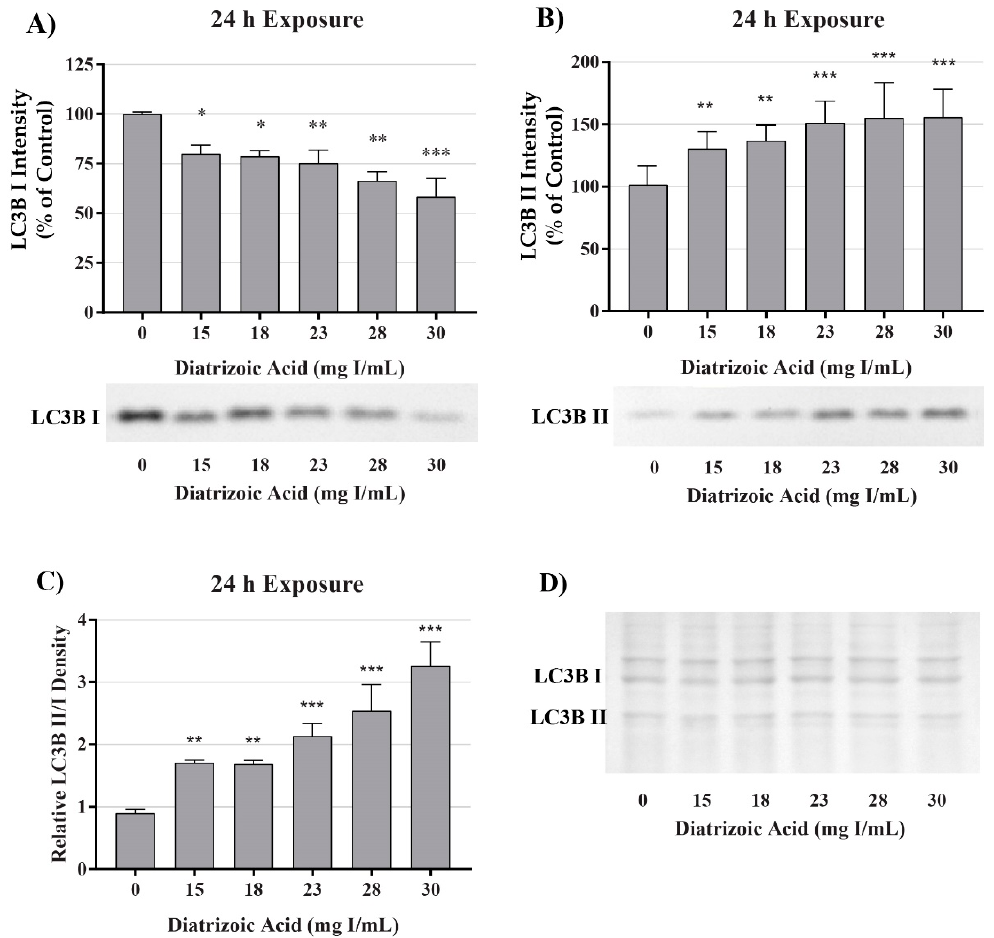
Figure 8. Diatrizoic acid effects on LC3B expression in HK-2 cells following 24 h exposure. DA induced mitophagy following 24 h exposure. Representative blots and cumulative densitometry included for LC3BI ( A ), LC3BII ( B ) exposure, and LC3BII/LC3BI ratio ( C ) following 24 h exposure to DA. Memcode protein staining of LC3BI and II blot loaded with 40 µg protein ( D ). Statistical difference from 0 mg I/mL diatrizoic acid depicted by an asterisk (* p < 0.05, ** p < 0.01, *** p < 0.001). Values represent mean ± SEM for three independent experiments.